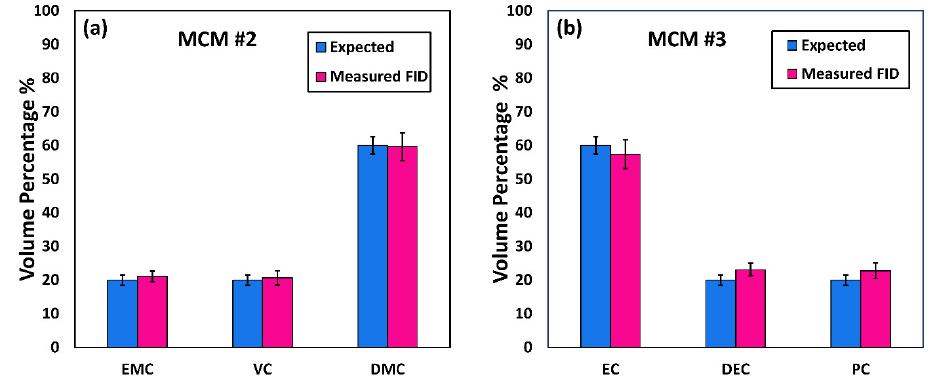
Figure 5. Expected and measured volume percentages of carbonates in MCM #2 ( a ) and MCM #3 ( b ) determined with GC×GC/FID.